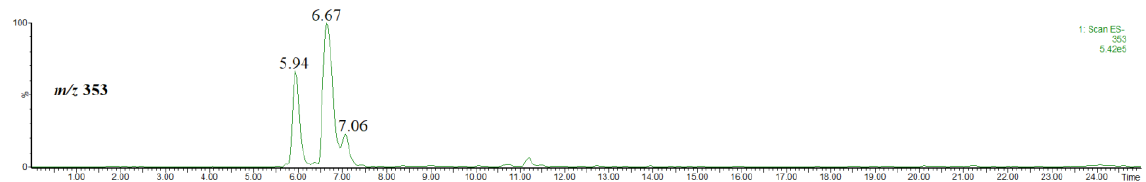
Figure 1. Single ion chromatogram of the ion at m/z 353, thus the [M-H] − ion of chlorogenic acid and its isomers.